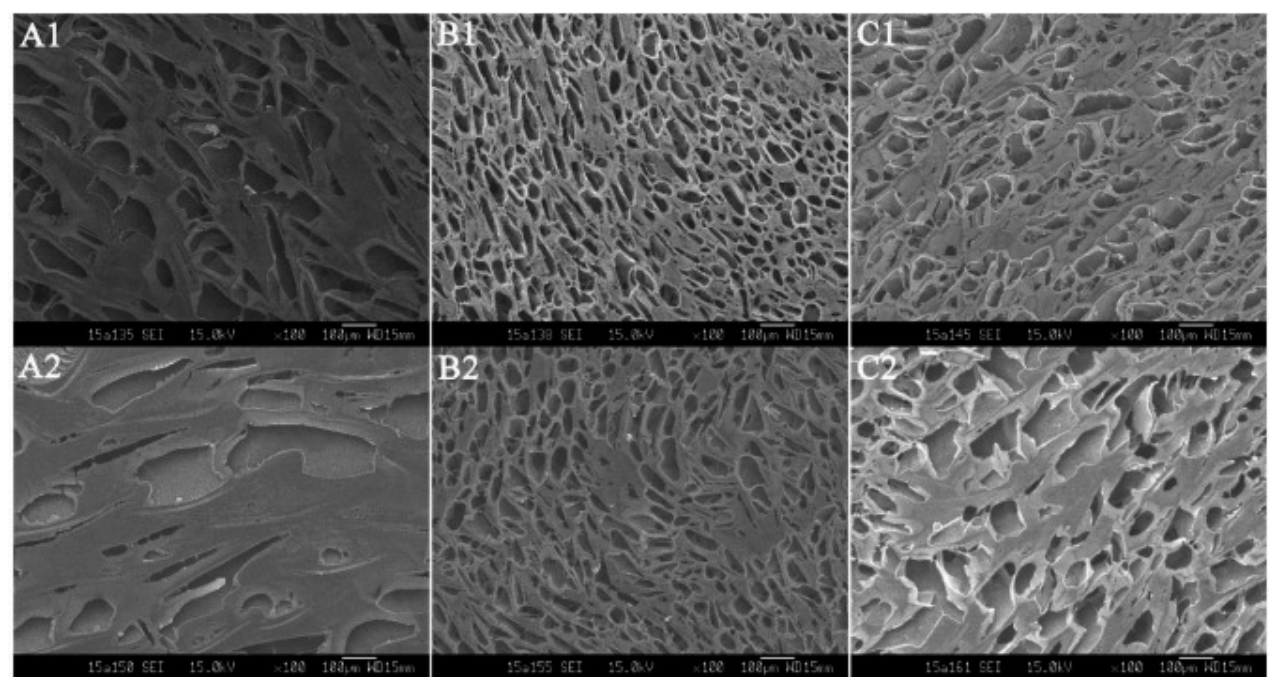
Figure 6. Ni et al. revealed ( A ) in vivo dwelling time of marketed bear bile eye drops and ad- vanced formulation displayed by fluorescence-gel formulation, the residence time was remarkably longer in advanced formulation compared to marketed drops; ( B ) the retention time of marketed bear bile and advanced formulation, where ** p < 0.01 [75].